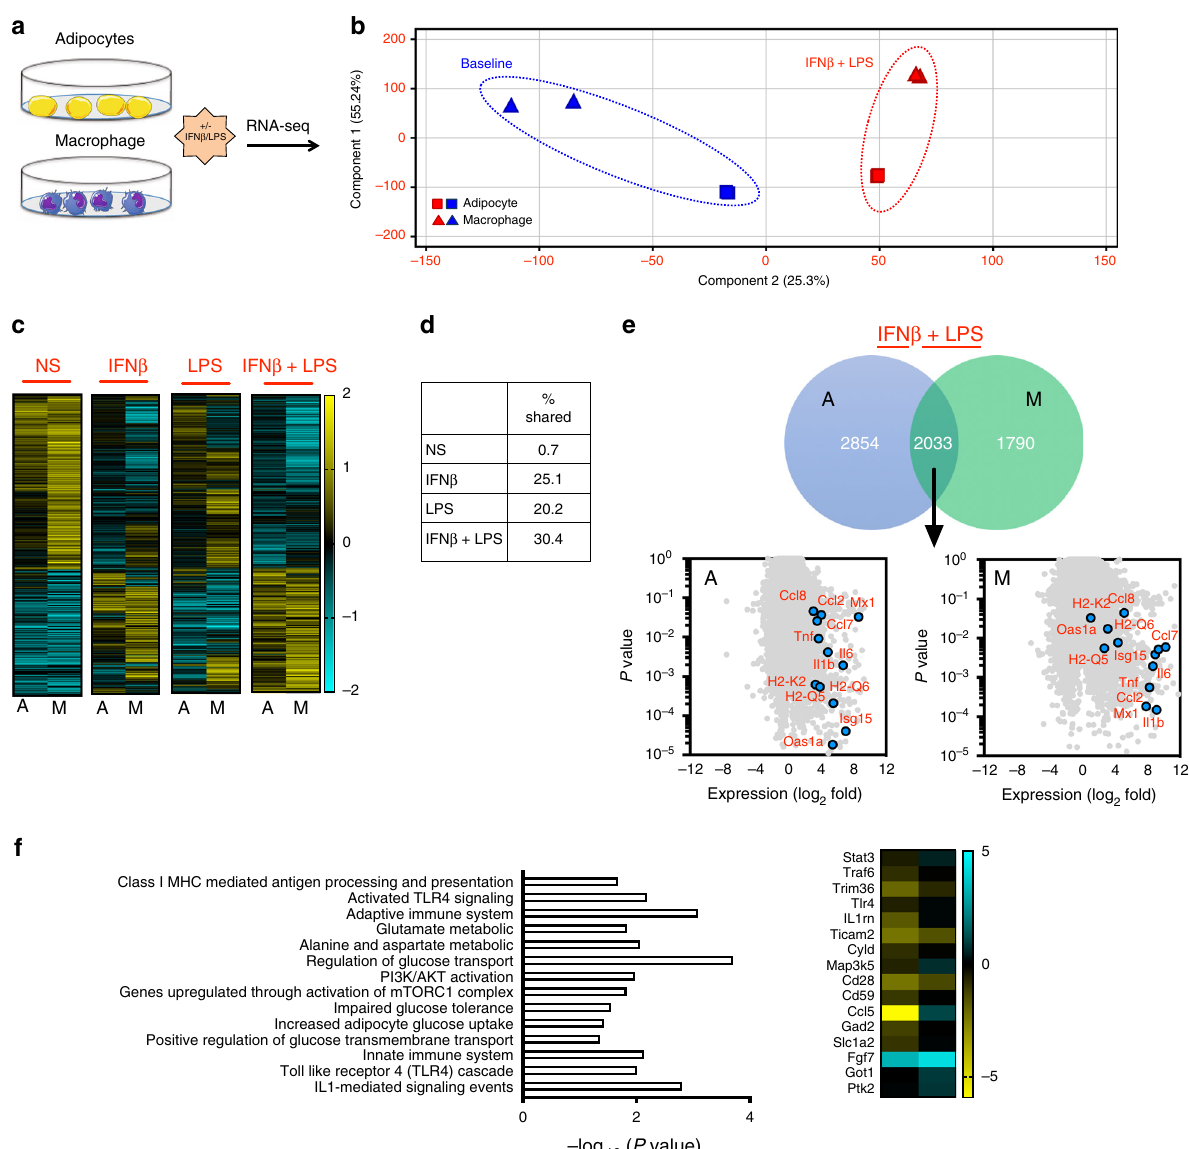
Fig. 2 Type I IFN/IFNAR axis drives convergence between adipocyte and macrophage in fl ammatory gene signature. Adipocytes and macrophages isolated from chow-diet-fed WT mice were treated with (NS), IFN β (250 U/ml) and/or LPS (100 ng/ml) and subjected to RNA-seq analysis. a Schematic overview. b Principal component analysis of RNA-seq analysis, distance of component 2 ( X -axis) delineates the similarity of gene expression patterns between cell types. c Heat maps of RNA-seq analyses in adipocytes and macrophages treated under indicated conditions. d Percent of shared genes between adipocytes and macrophages treated under indicated conditions. e Venn diagram (top) and volcano plots (bottom) of genes differentially expressed under IFN β + LPS treatment in adipocytes and macrophages. f Adipocyte ontology pathways and heat map of representative genes distinct to IFN β + LPS treatment. a − f A single experiment, n = 2/condition. A denotes adipocytes. M denotes macrophages. Source data are provided as a Source data fi